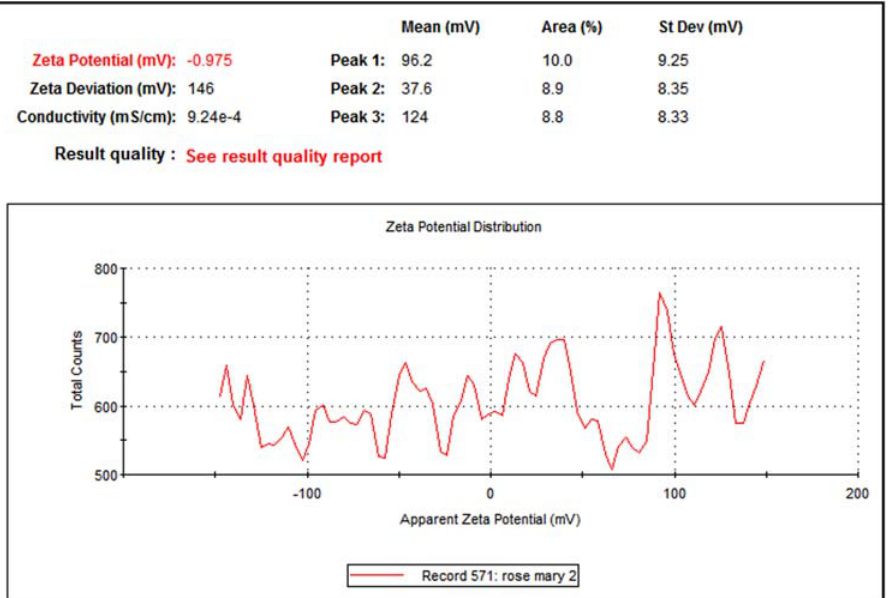
Figure 4: Zeta potential distribution of the biosynthesized AgNPs prepared with aqueous R. o ffi cinalis leaf